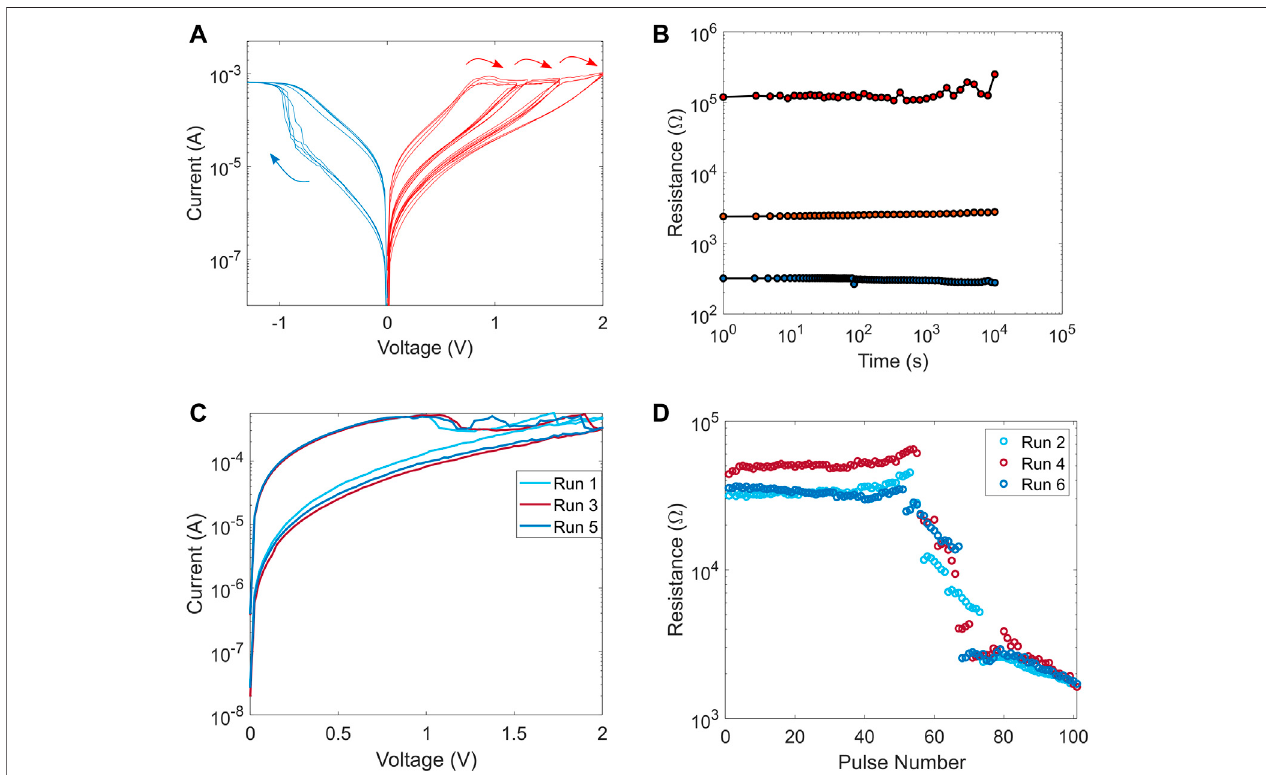
FIGURE4|(A) MultipleresistancestatesachievedinanimplantedSiO x devicebychangingthestopvoltagesintheresetsweep. (B) Multipleresistancestatesinan implanted SiO x devicelasting morethan 30,000 s (C) and (D) showsgradual resistance programming ofanimplanted SiO x device.Devicesareresetbyvoltage sweeps (C) and set by voltage pulses (D) . Data are shown for three consecutive set and reset cycles. The device is set to LRS by applying voltage pulses to the gate of serial transistor; the magnitude of the voltage pulse increases linearly as pulse number increases during